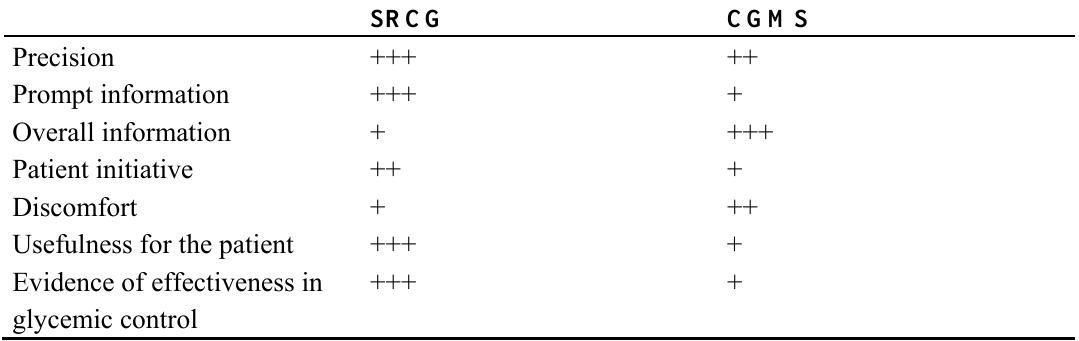
Table 2. Differential characteristics of the SRCG and